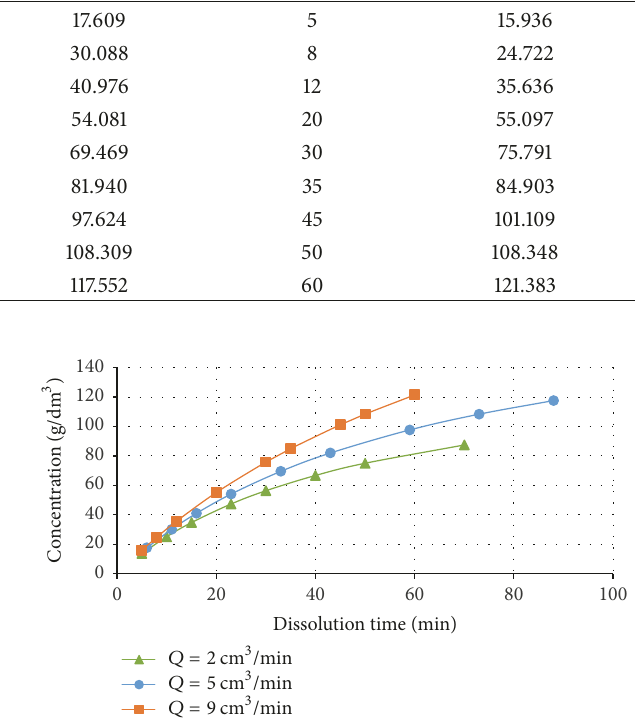
Figure 3: Transient dissolution test curve of rock